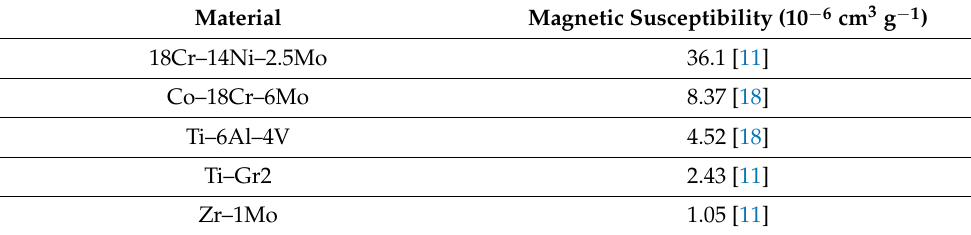
Table 7. Comparison of the magnetic susceptibility coefficients of common medical materials.